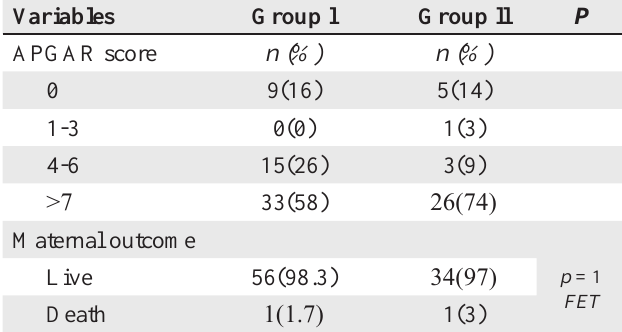
Table 3: APGAR score according to the admission status